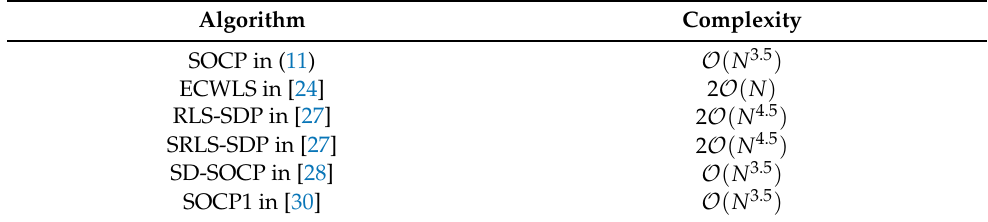
Table 1. Worst-case computational complexity of the considered